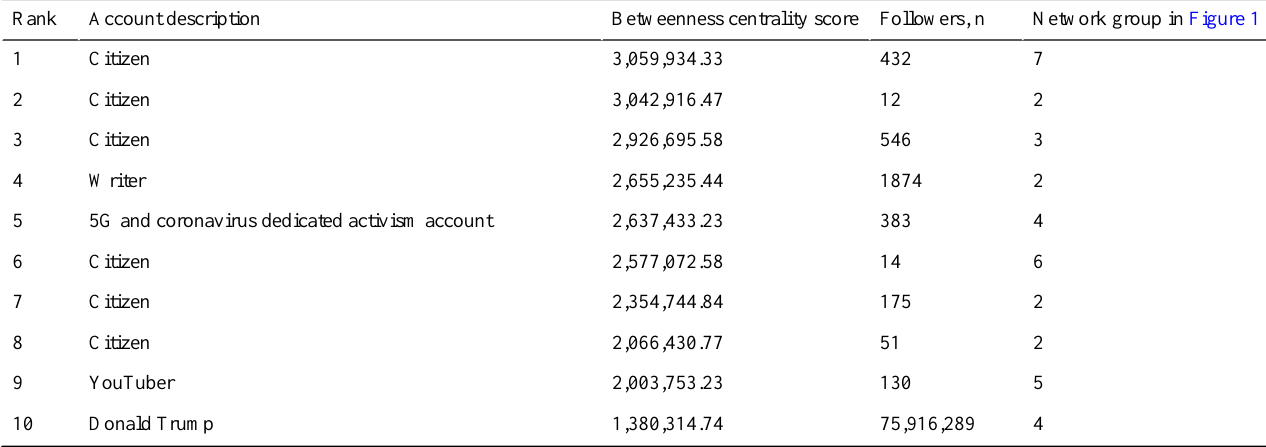
Table 1. Influential users ranked by their betweenness centrality